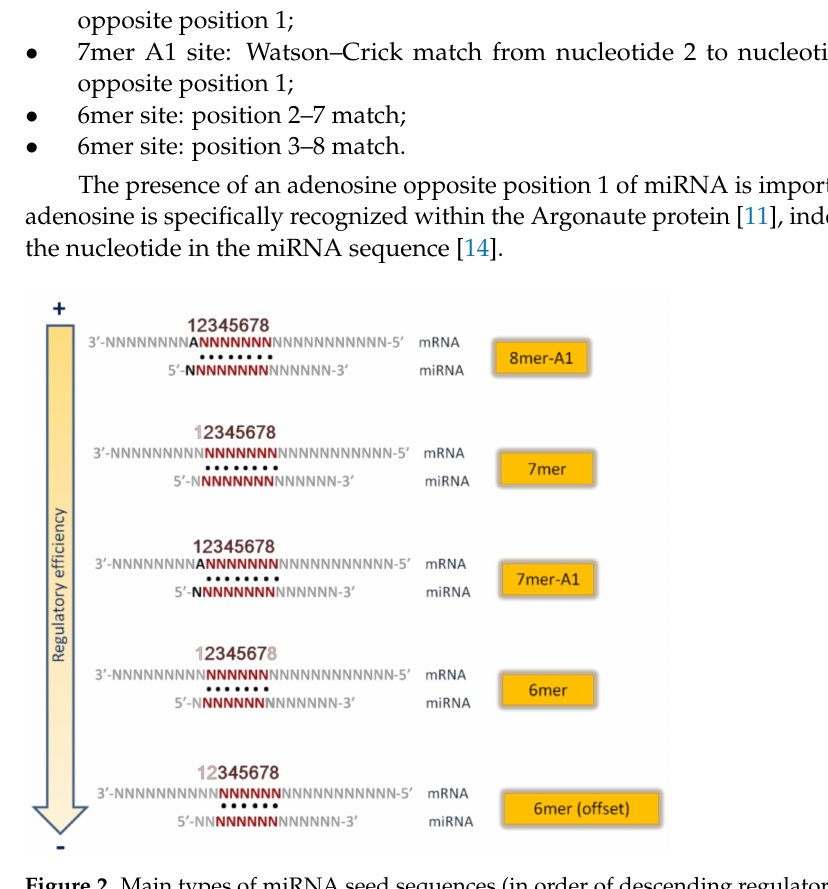
Figure 2. Main types of miRNA seed sequences (in order of descending regulatory